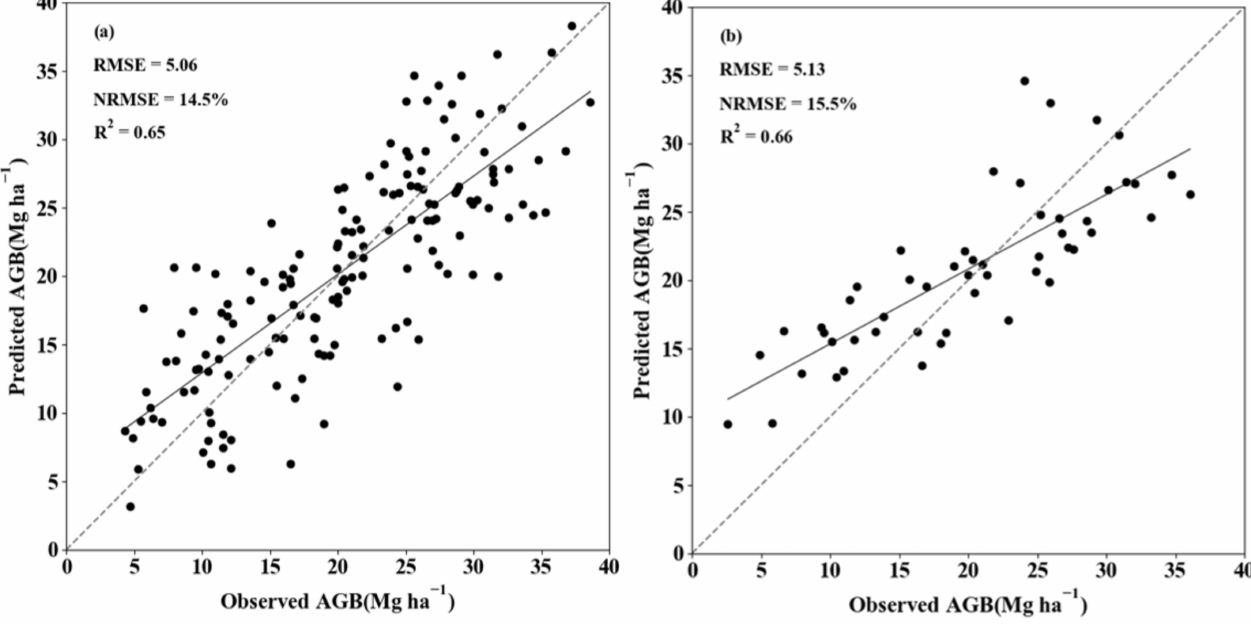
Figure 10. Comparison of observed and predicted AGB by the OLS model with ( a ) training samples and ( b ) testing